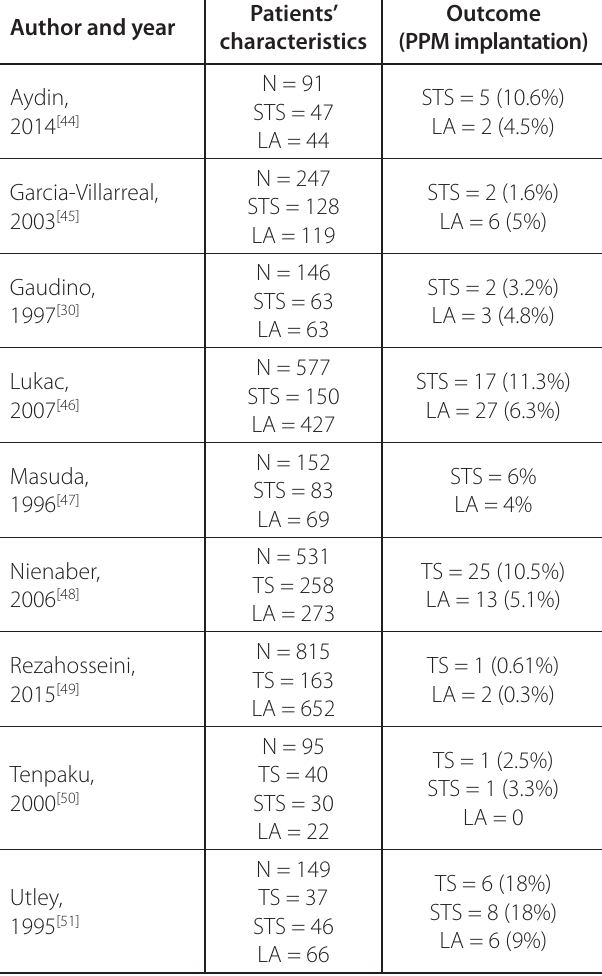
Table 5 . Rate of PPM in mitral valve surgery considering the approach to the mitral